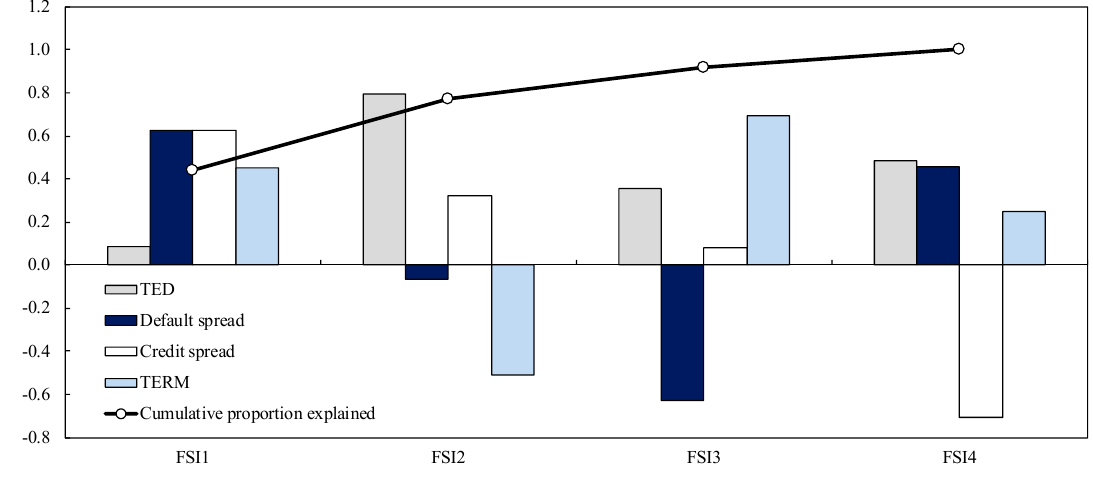
Figure 1. FSI1 to FSI4 are the first to fourth principal components obtained by applying principal component analysis to the set of financial risk indicators; TED, Aaa-10Y, Baa-Aaa, and TERM. Here, TED is Ted spread, Aaa-10Y is the yield spread between Aaa-ranked corporate bonds and Treasuries with 10-year constant maturities (default spread), Baa-Aaa is the yield spread between Baa-ranked and Aaa-ranked corporate bonds (credit spread), and TERM is the yield spread between Treasuries of 10-year and three-month constant maturities. We interpret these four principal components as follows. FSI1: Degree of stress in general financial markets. FSI2: Financial tightening in the banking sector or a surge in liquidity risk. FSI3: Monetary policy stance or recession risk. FSI4: Risk premium on corporate bond with a relatively high credit.